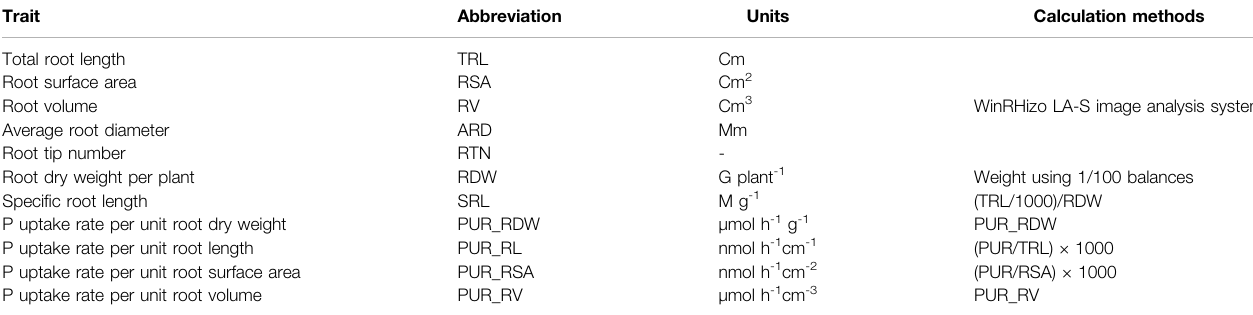
TABLE 1 | Summary of traits and their calculation methods in hydroponic culture.